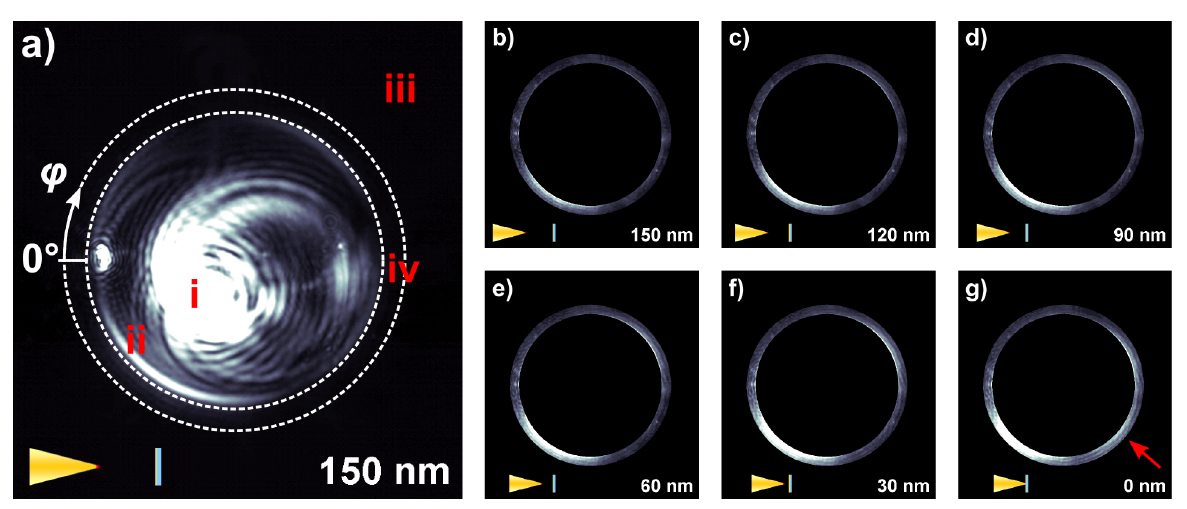
Figure 4: k-space patterns recorded while approaching a gold-coated cover slip to the SNOM probe. Tip-sample spacings are indicated in the lower right corner of the respective images and the corresponding pictographs in the lower left corner. Panel a) shows raw data, the dashed circles mark the region of interest (ROI, labeled iv). Panels b)-g) represent the evolution of the k-space pattern during approach. For clarity, the data are limited to the ROI and are rescaled to the 90th percentile of all pixel intensities within the ROI in panel